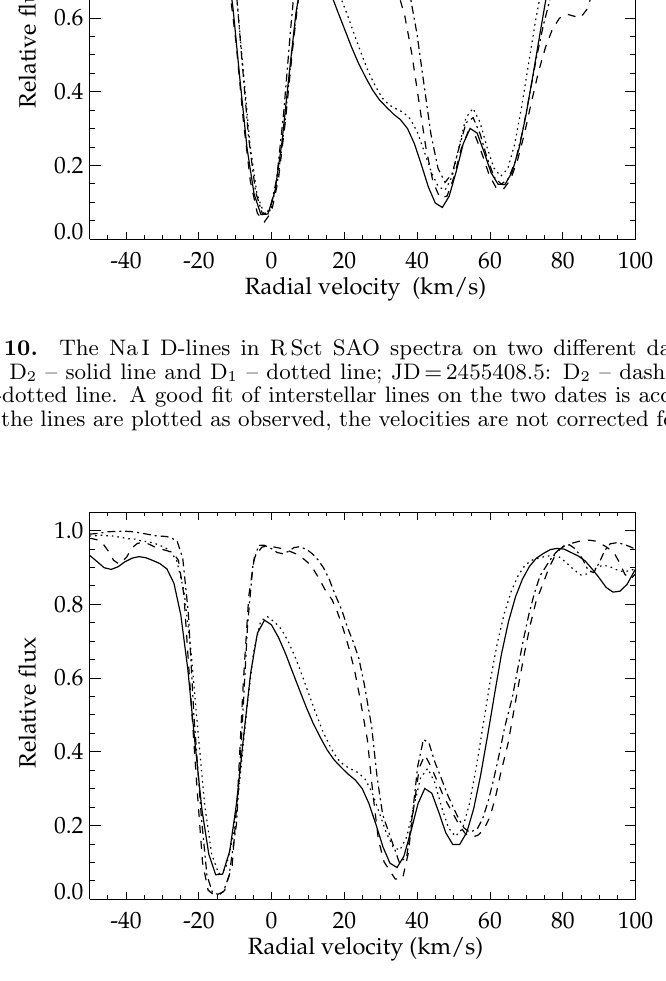
Fig. 11. The Na I D-lines in R Sct SAO spectrum on JD = 2455464.3: D 2 – solid line, D 1 – dotted line. Dashed and dash-dotted lines are for the NARVAL spectrum on JD = 2454621.6. Differently from Figure 10, in this figure the solar velocity is taken into